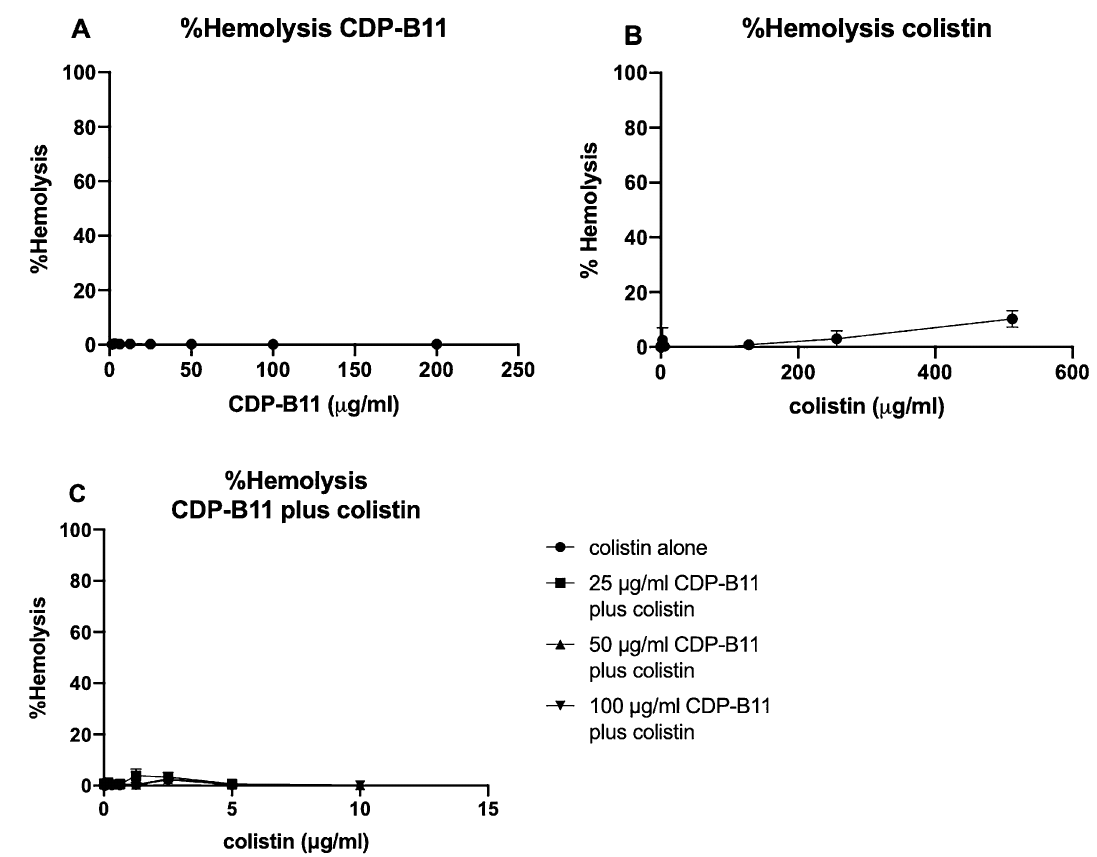
Figure 5. Percent red blood cell hemolysis of CDP-B11 alone, colistin alone or CDP-B11 plus colistin. ( A ) Percent red blood cell lysis of CDP-B11 alone; ( B ) Percent red blood cell hemolysis of colistin alone; ( C ) Percent red blood cell hemolysis of CDP-B11 plus